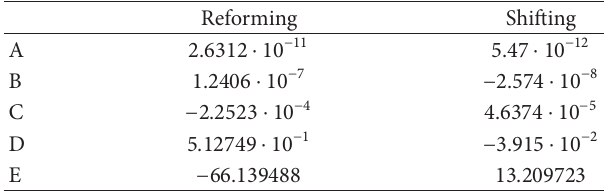
Table 2: Values for the calculation of the equilibrium constant 𝐾